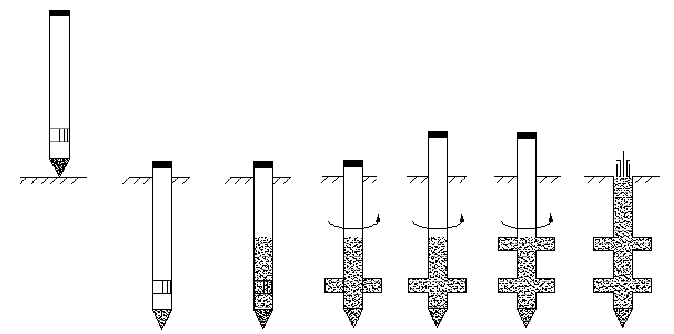
Figure 4. The process of construction technology of nodular piles.